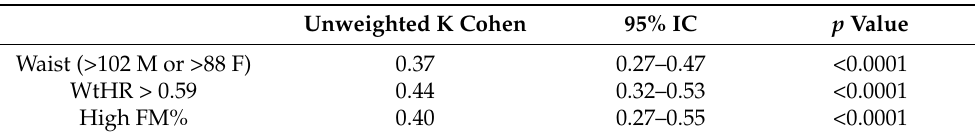
Table 2. Reliability between the classical definition of obesity, based on BMI value, and the main measures of central obesity.